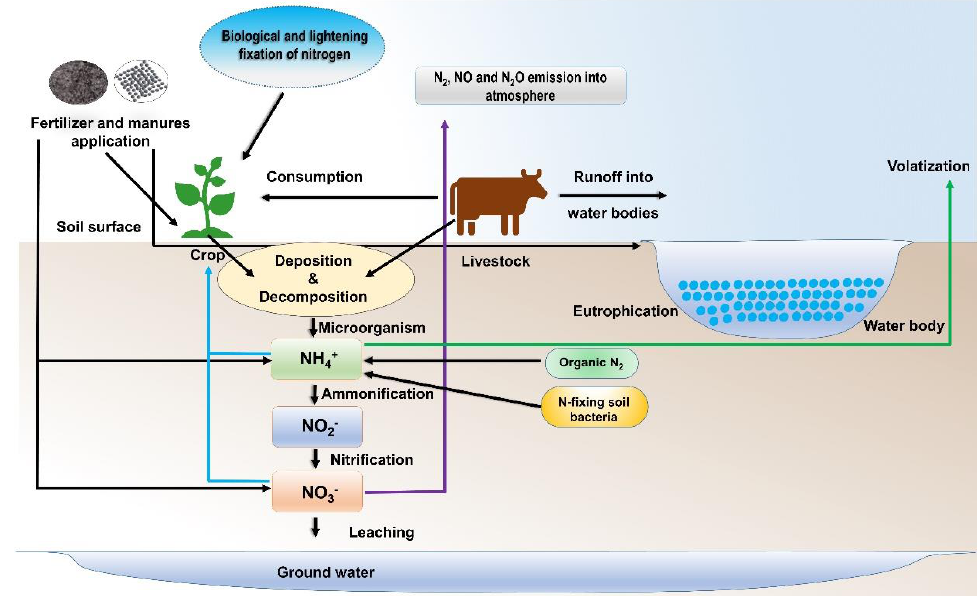
Figure 2. Global N cycle in relation to the soil – plant